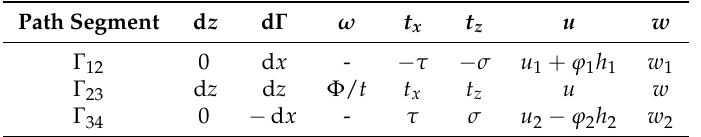
Figure A1. Integration path Γ chosen for the evaluation of the J -integral for the CTE. Table A1. Calculation of J